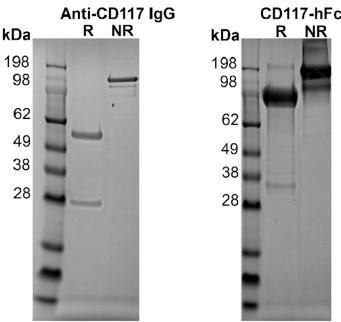
Figure 2. On the left, purified recombinant reformatted fully human IgG and recombinant CD117-hFc fusion protein in 4%–12% SDS-PAGE. Size standard is SeeBlue Plus 2 molecular mass marker (Invitrogen). The stained gel of H1- κ as a representative purified human anti-canine CD117 IgG antibody showed the light-chain at ~25 kDa and the heavy chain at ~50 kDa under reducing (R) conditions, and the full IgG at ~145 kDa under nonreducing (NR) conditions. On the right, purified Fc fused canine CD117 extracellular domain (ECD) showing the presence of the monomeric form of the CD117-hFc at ~84.2 kDa under reducing conditions, and a dimer of ~168.4 kDa under nonreducing